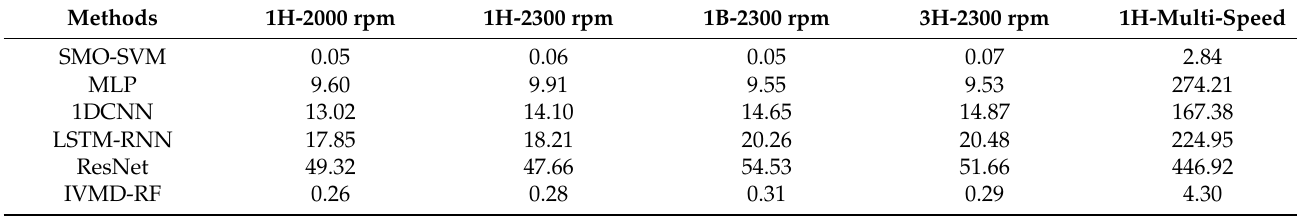
Table 7. Comparison of training time of various algorithms (s).